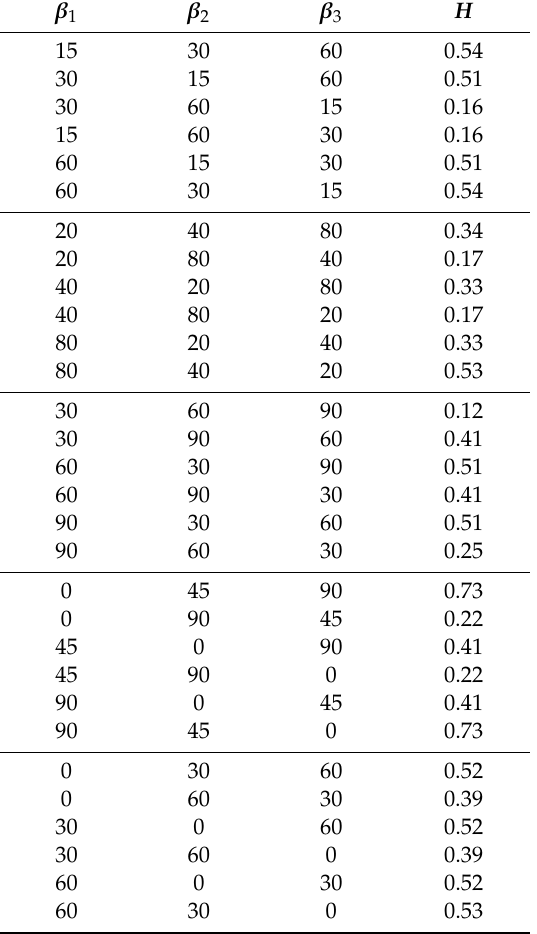
Table 6. Singularity-free maximum angular momentum values for various mixed skew